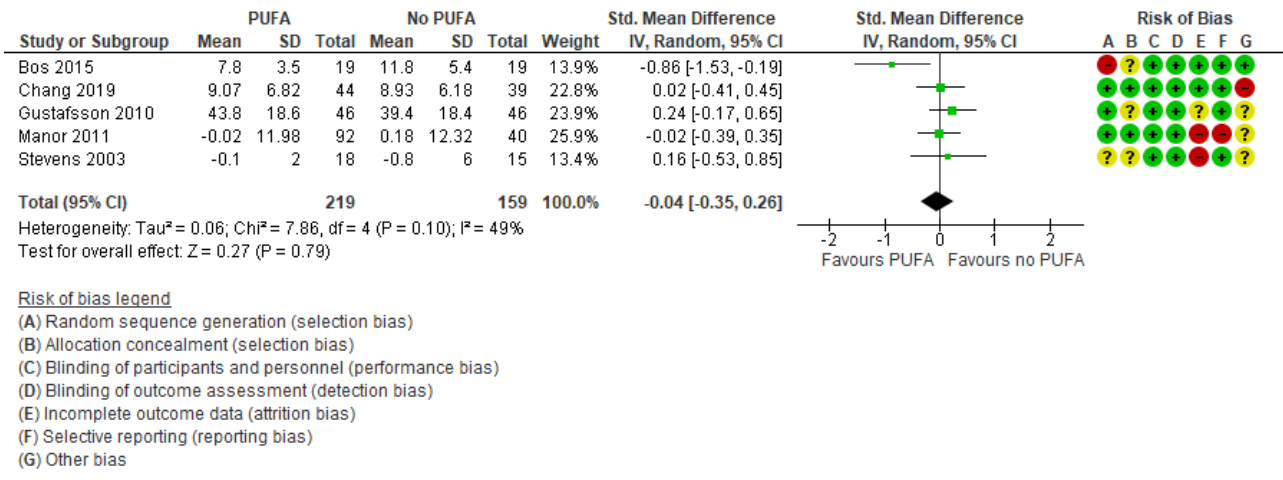
Figure 6. Forest plot of comparison: PUFA vs. placebo, outcome: teacher-reported behavioral difficulties (end of treatment). Green square indicates summary estimates of the individual studies. Black diamond indicates total summary effect estimate.